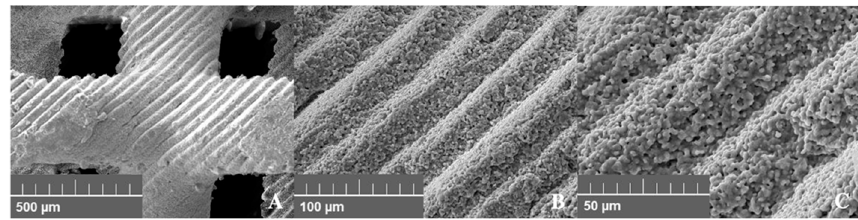
Figure 1. Structure of 3D printed hydroxyapatite (HA)/tricalcium phosphate (TCP) scaffold (SEM, 20.0 kV). ( A ) 100 × , ( B ) 500 × , ( C ) 1000 × .